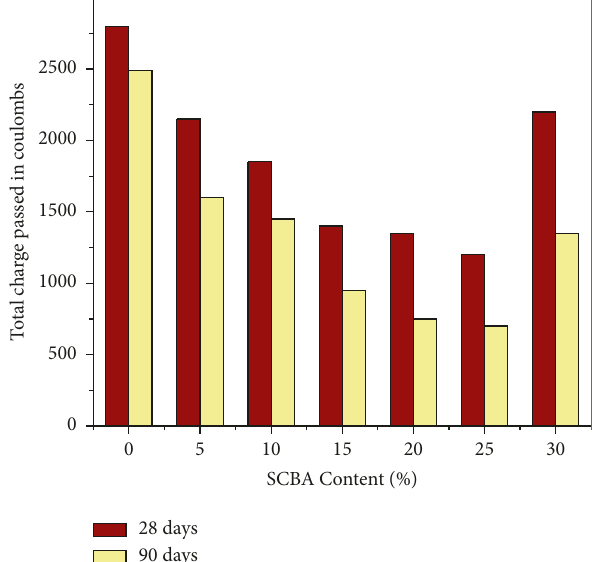
Figure 27: Chloride permeability of SCBA containing concrete [78].